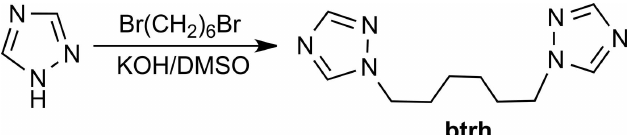
Figure 1 Synthesis of